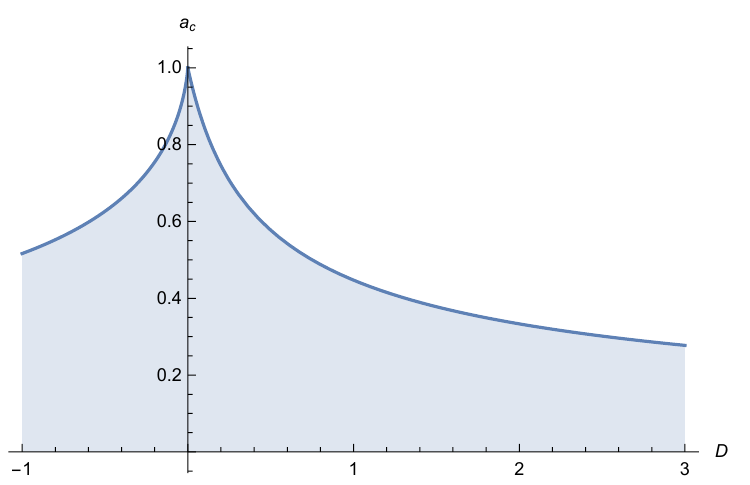
Figure 1 . Critical value a c as a function of D . For a > a c , we have R 0 ( π/ 2) 6 = 0 when D < 0 , and R 0 (0) 6 = 0 when D > 0 . For points in the shaded region, R 0 (0) = R 0 ( π/ 2) = 0 is